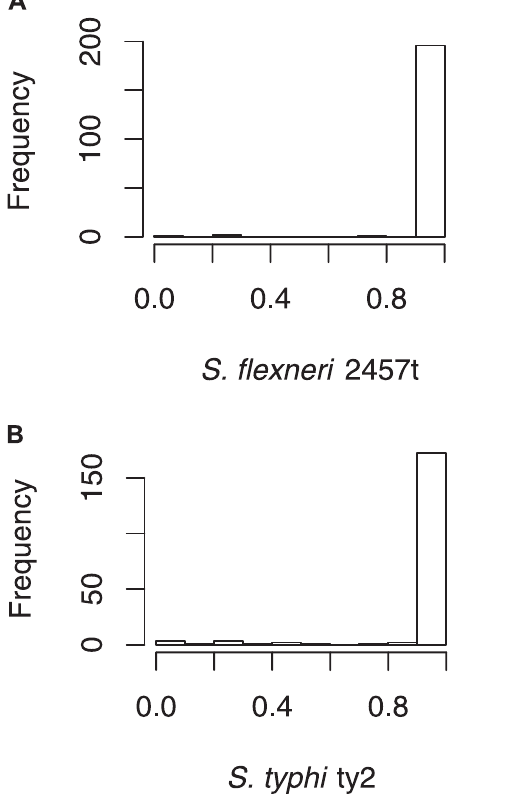
Figure 10. Histogram of Intersection Ratios between Table Entries (after Removing Trivial Entries and Selfish DNA) in the comparison of S. flexneri 2457t and S. typhi ty2 The ratio is calculated as the intersection length divided by the length of the shortest entry. (A) Ratios in S. flexneri 2457t and (B) ratios in S. typhi ty2. We set the default value of dupPerc to 50% since most of the histogram values are larger than that. DOI: 10.1371/journal.pcbi.0020075.g010